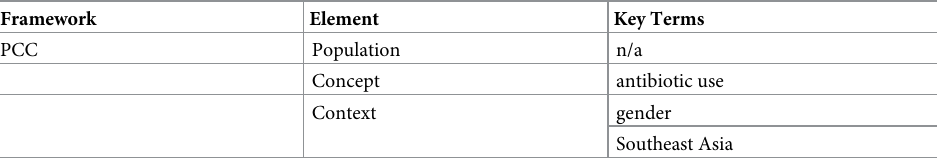
Table 1. PCC framework for search strategy